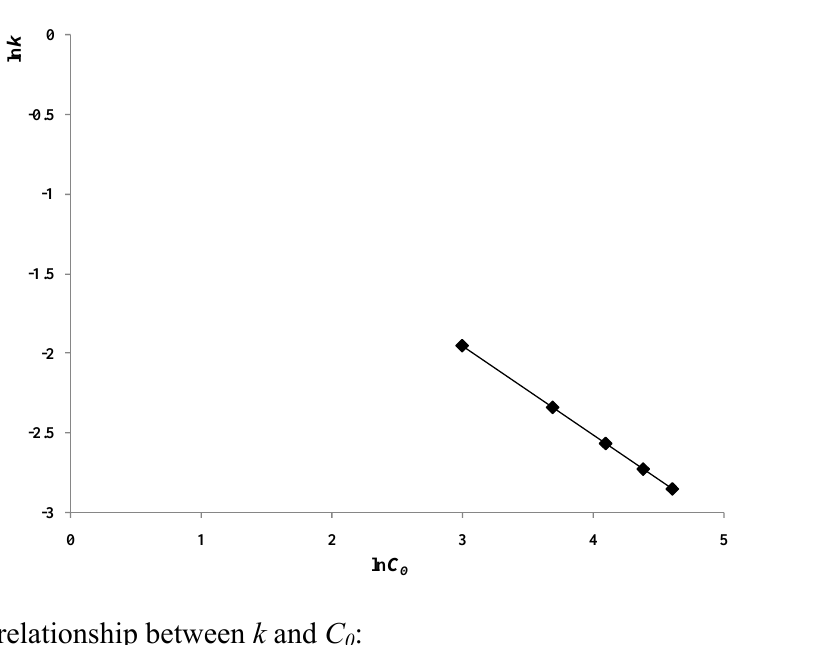
Figure 4. Varying trend of ln k to ln C